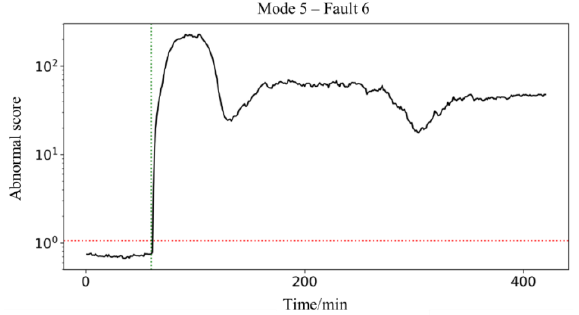
Figure 12. The detection result of the DLAN model for Mode 5 fault 6.